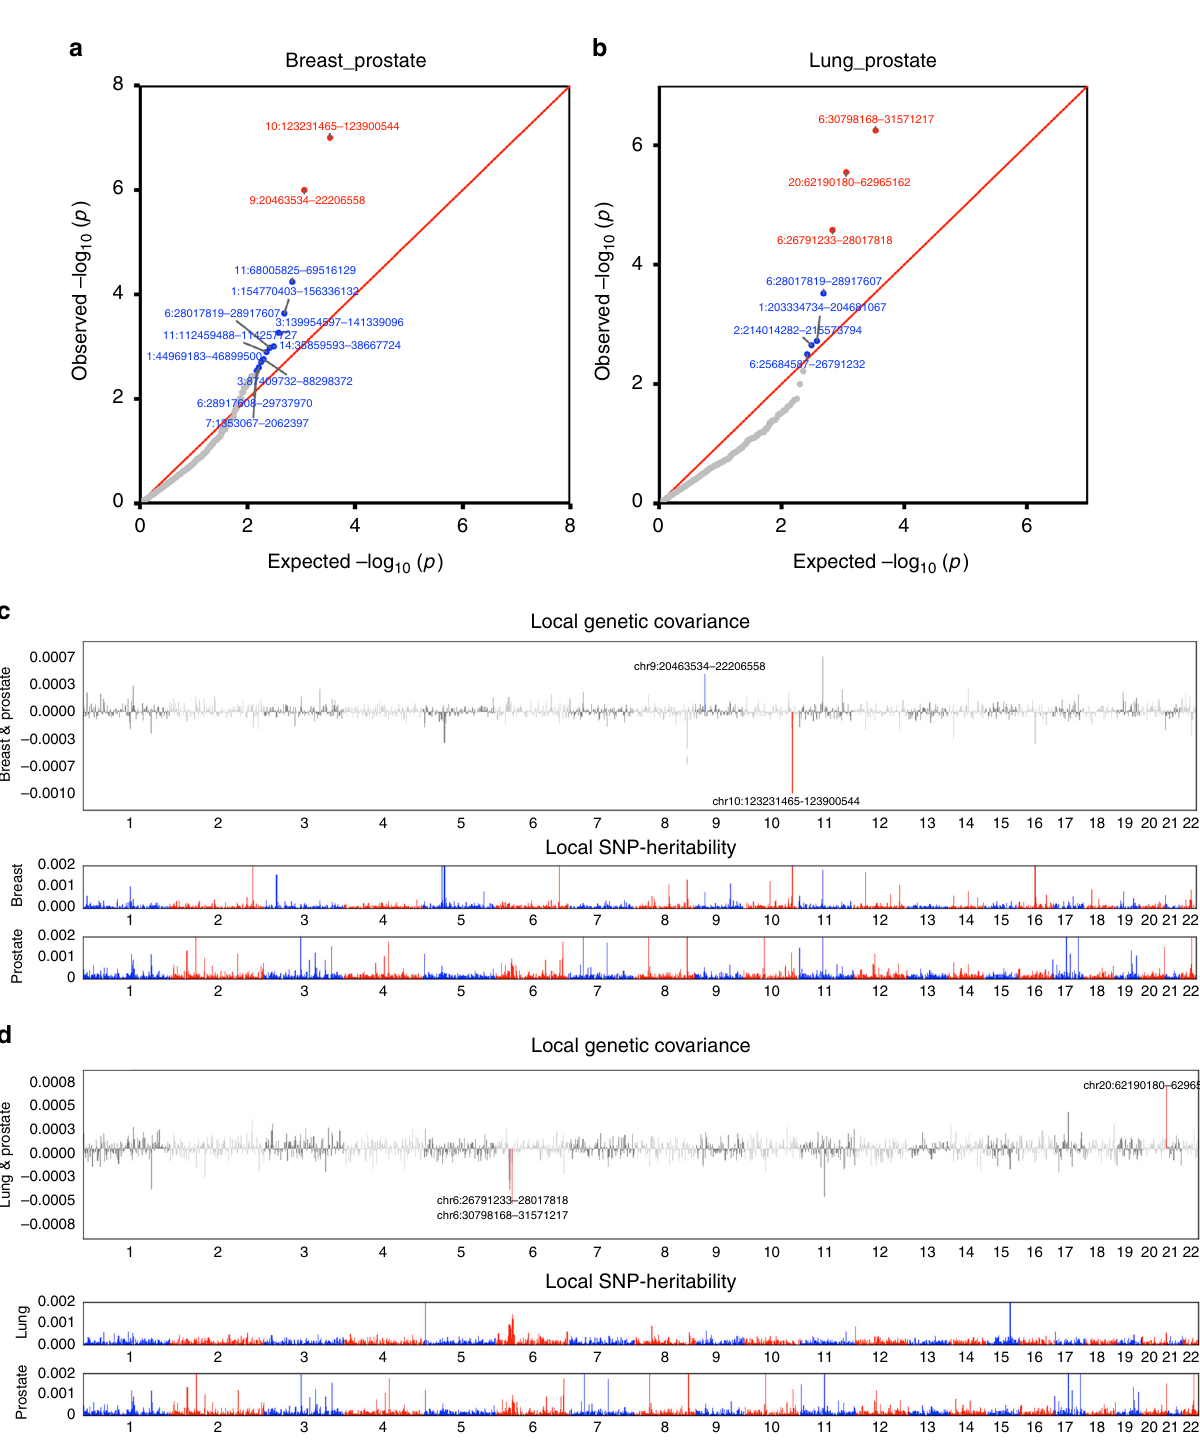
Fig. 2 Local genetic correlation between breast, lung and prostate cancer. The region-speci fi c p -values for the local genetic covariance for breast and prostate cancer are shown in a , and for lung and prostate cancer in b . Each dot presents a speci fi c genomic region. In the QQ plots, red color indicates signi fi cance after multiple corrections ( p < 0.05/1703 regions compared), and blue color indicates nominal signi fi cance ( p < 0.05/15 pairs of cancers compared). Manhattan-style plots showing the estimates of local genetic covariance for breast and prostate cancer ( c ), and for lung and prostate cancer ( d ). Although breast and prostate cancer only show modest genome-wide genetic correlation, two loci exhibit signi fi cant local genetic covariance. Similarly, albeit the negligible overall genetic correlation for lung and prostate cancer, three loci present signi fi cant local genetic covariance. In the Manhattan plots, red color indicates even number chromosomes and blue color indicates odd number